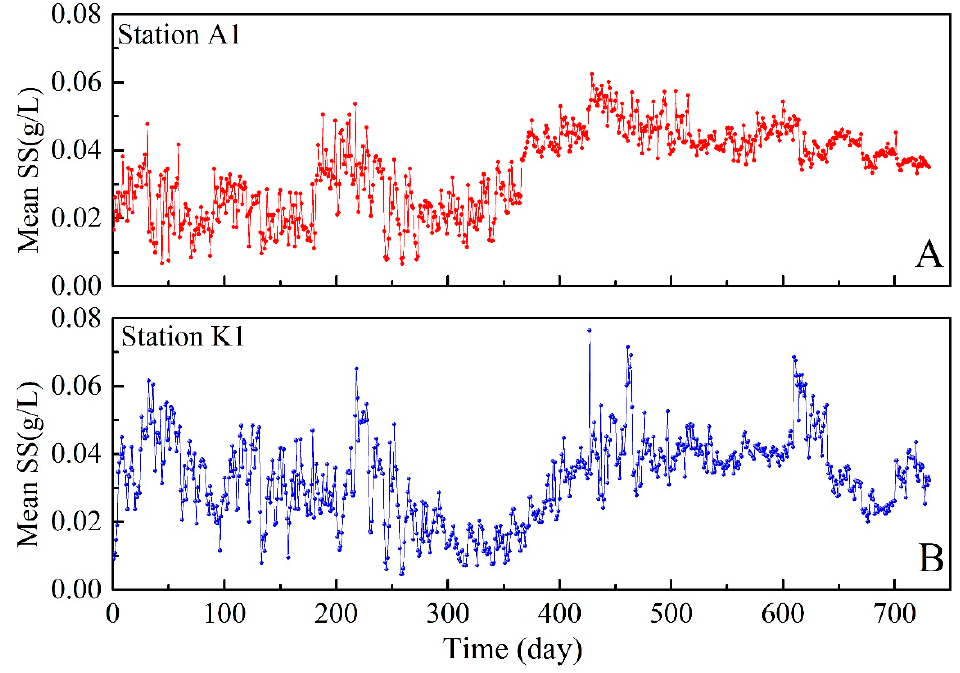
Figure 4. Daily mean suspended solids (SS) from 2007 to 2008 at station A1 ( A ) and K1 ( B ). Table 3. Summary statistics for the suspended solids (SS) data at stations A1 and K1 in 2007 and 2008.